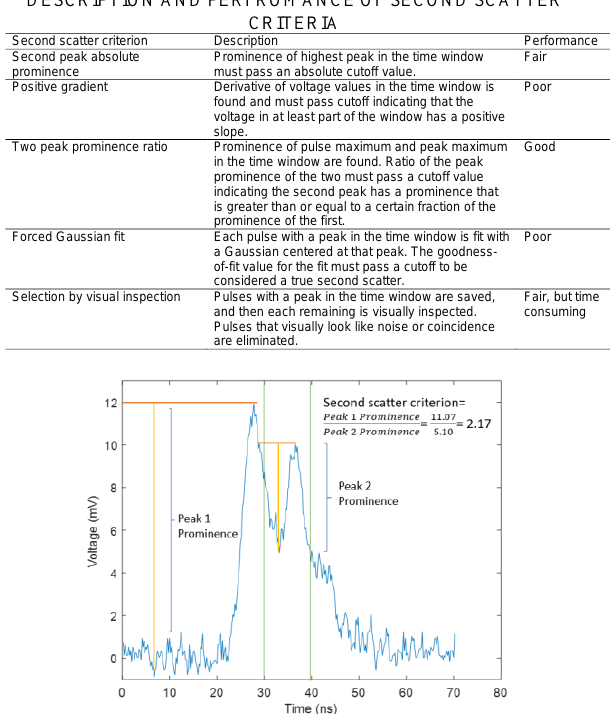
Fig. 8. Demonstration of second scatter criterion using the two peak prominence ratio method. In generating the neutron images to evaluate this method, the second scatter criterion for this method was ranged over values between 1.5 and 10.